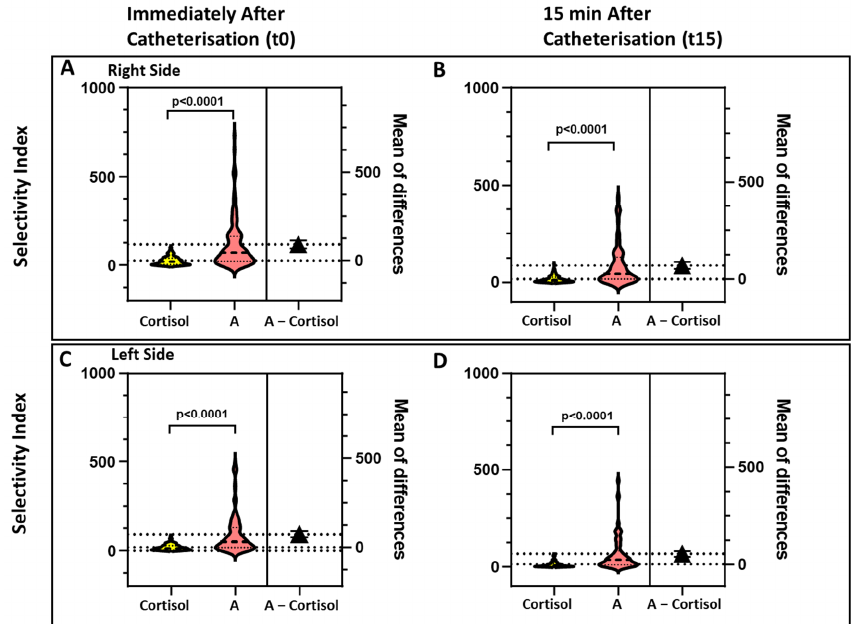
Figure 2. The violin plots show the values of the selectivity index for cortisol (SIC) and androstenedione (SIA), measured at t0, i.e., immediately after starting catherization (Panels A and C ), and 15 min afterward (t15, Panels B and D ), on the right side (Panels A and B) and left side (Panels C and D ). For both sides and time points the SIA was bilaterally higher than the SIC in a highly significant manner.